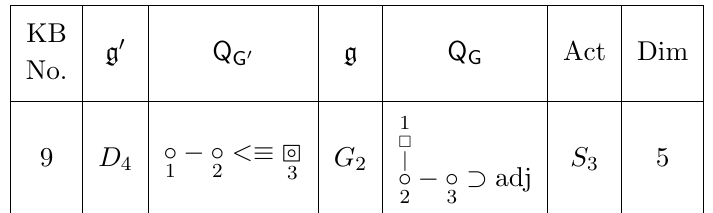
Table 7 . Ninth Kostant-Brylinski Result, Corresponding Coulomb Branch Quivers, Action and Dimension. The (cid:27) adj is used to denote an adjoint node ([15, 16]). The action of the permutation group of three elements is denoted by S 3 .